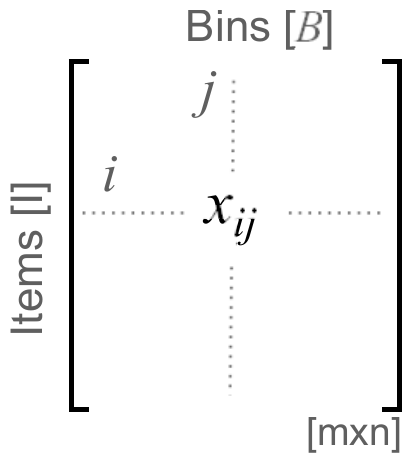
Figure 1. Decision variable x ij in basic